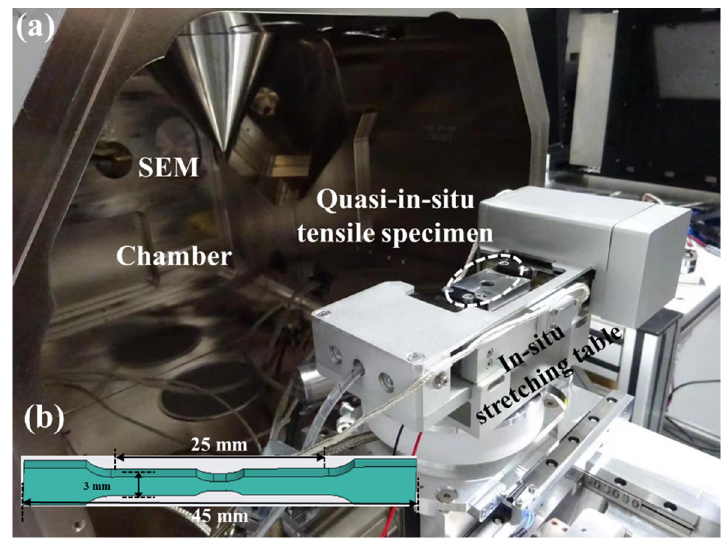
Figure 1. ( a ) In situ tension table and ( b ) in situ tensile